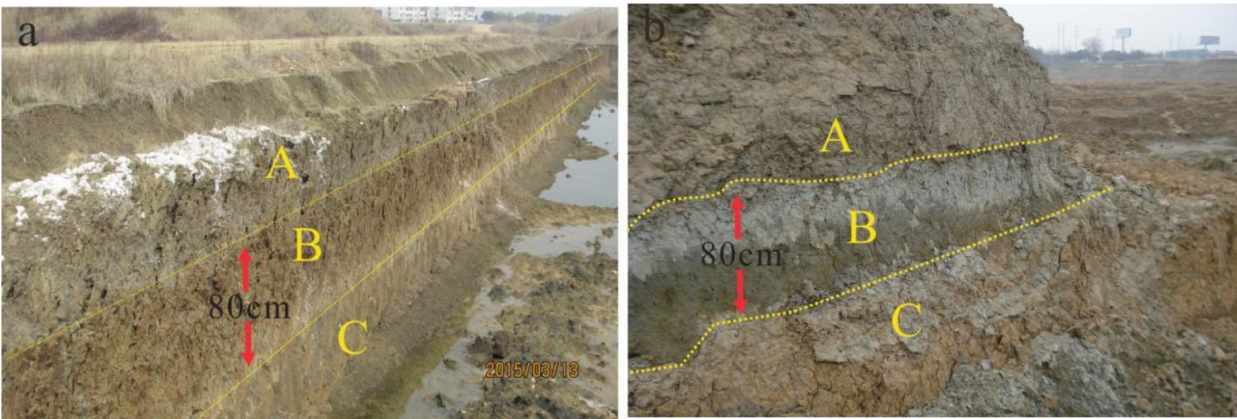
Figure 3. The sequence layers of the Taihu Lake bottom (water was temporarily drained away for the excavation, and the area is now covered by water again) near the Yuanshan site of Xishan Island ( a ) and Shihu ( b ). ( a ) The middle marker silty layer (B) is oxidized and shows a reddish-brown color after being exposed to air for many days. ( b ) The fresh lake bottom layers of Shihu near Suzou city. The fresh silty marker layer (B) has a bluish-gray color sandwiched by a lower loess (C) layer and an upper modern mud layer